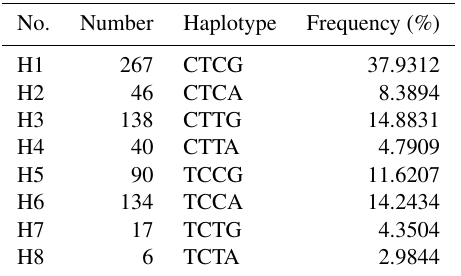
Table 2. The results of haplotype analysis of the Fbxl5 gene.